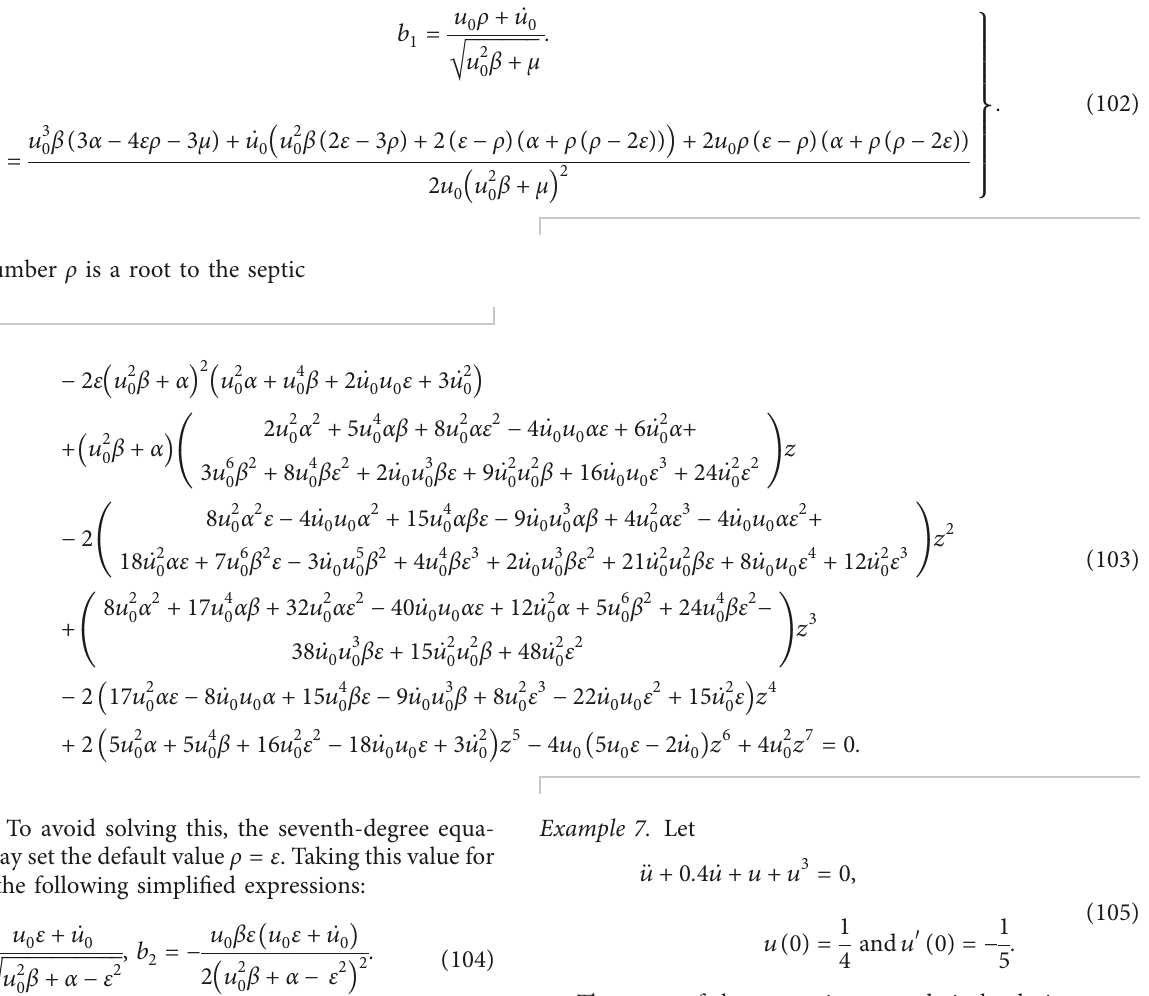
The error of the approximate analytical solution com- pared with numerical solution is